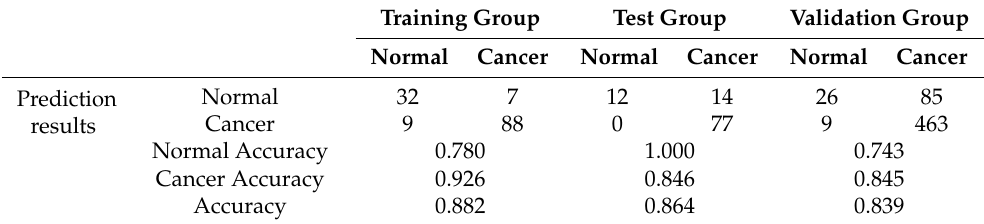
Table 2. Neural Diagnostic for the training, test and validation cohorts.